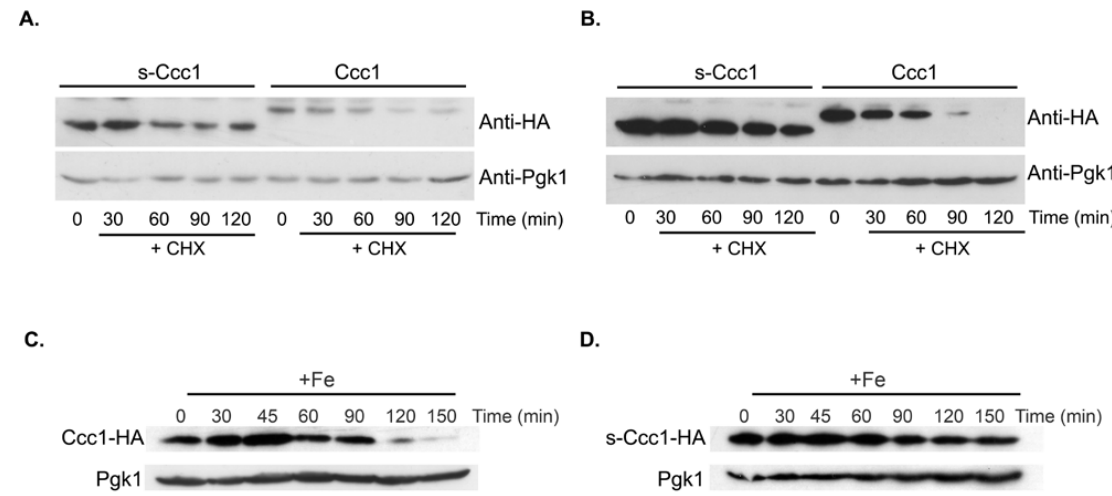
Figure 5. s-Ccc1 is more stable than Ccc1. Ccc1-HA and s-Ccc1-HA protein stability was assessed by cycloheximide (CHX) chase assay. ∆ ccc1 expressing either the Ccc1 or s-Ccc1 (plasmids − 690CCC1-HA and +110CCC1-HA, respectively) were grown to mid-exponential phase and left untreated ( A ) or treated ( B ) with 2 mM of FeSO 4 for 30 minutes. CHX was then added to a final concentration of 100 µ g/mL. Cells were collected at the indicated time points and protein extracts were immunobloted using an anti-HA antibody. Exponentially growing ∆ ccc1 cells, expressing ( C ) Ccc1-HA or ( D ) s-Ccc1-HA, were treated with 2 mM FeSO 4 , harvested at the indicated time points and examined by immunoblotting using an anti-HA antibody. Pgk1 levels were used as a loading control.